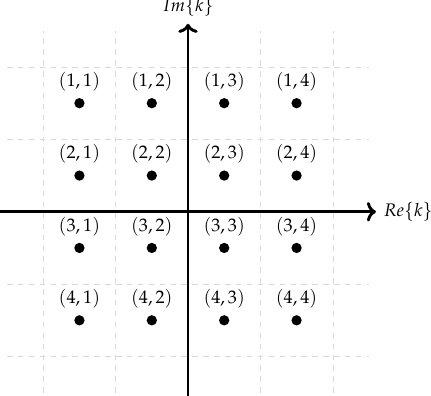
4 grid (Note that this is × 4 grid (note that this × < R , where R is k | | lead to numerical k | | < 3.5 k | |